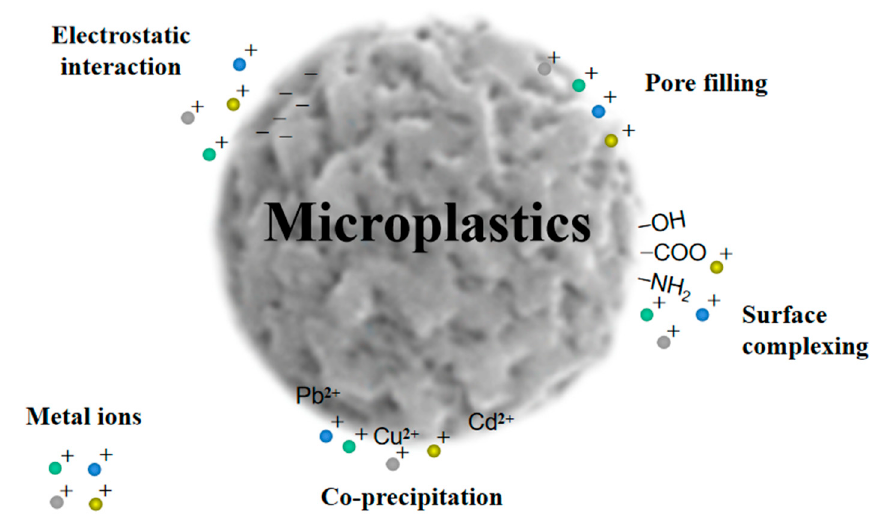
Figure 3. Possible adsorption mechanisms of heavy metals by MPs. Table 3. The range of concentrations of heavy metals is frequently detected in MPs. Reprinted with permission from Ref. [149]. 2017,Kutralam-Muniasamy, G.; Perez-Guevara, F.; Martinez, I.E.; Shruti, V.C.